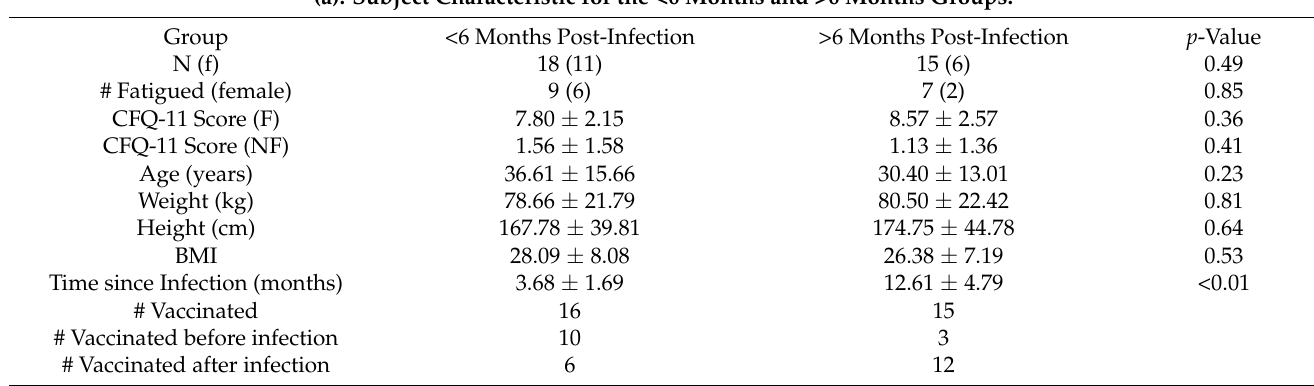
Table 1. ( a ). Subject characteristics for the <6 months and >6 months groups. ( b ). Sub-group characteristics and outcome of the FSS and FAS for the fatigued and non-fatigued groups at each time